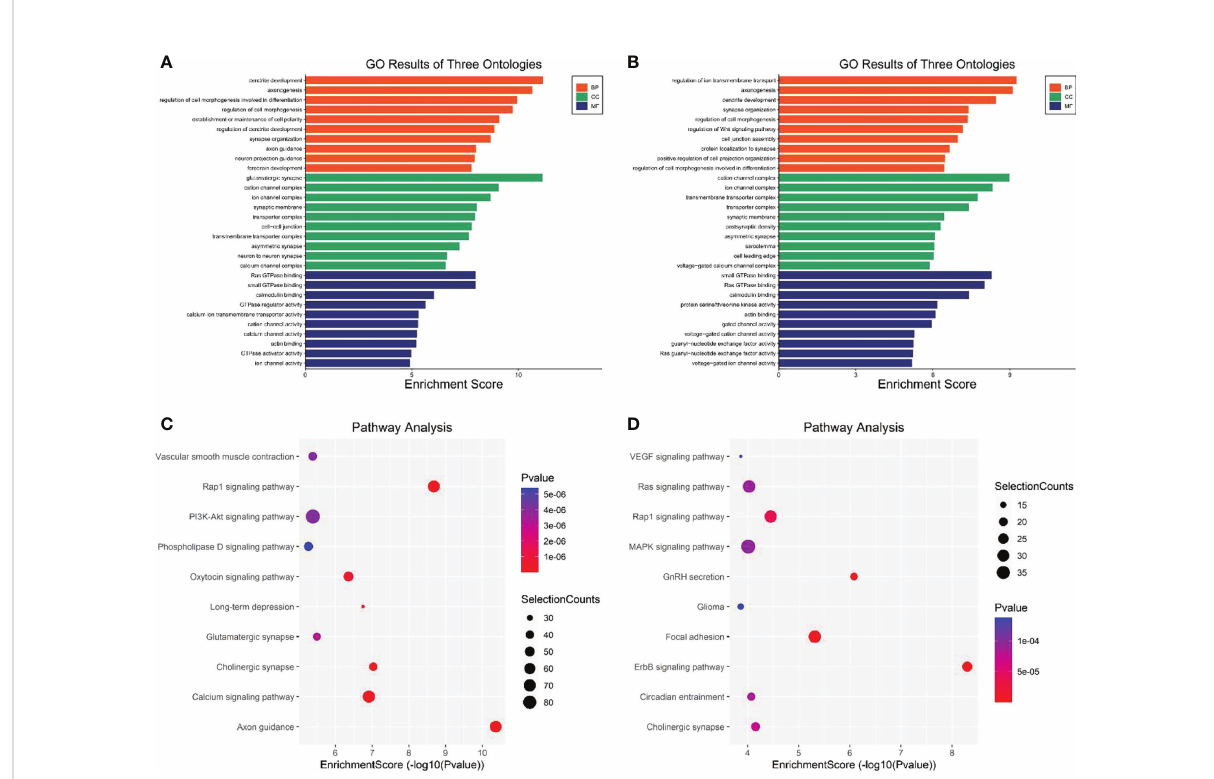
FIGURE 5 GO and KEGG pathway analysis of genes associated with the differentially expressed eccDNAs in CSF between MB and normal tissues. (A) Top 10 enriched BP, CC, and MF terms associated with the upregulated eccDNA genes. (B) Top 10 enriched BP, CC, and MF terms associated with the downregulated eccDNA genes. (C, D) KEGG pathway analysis of the upregulated and downregulated eccDNA genes, respectively. GO, Gene Ontology; KEGG, Kyoto Encyclopedia of Genes and Genomes; BP, biological processes; CC, cellular components, MF molecular